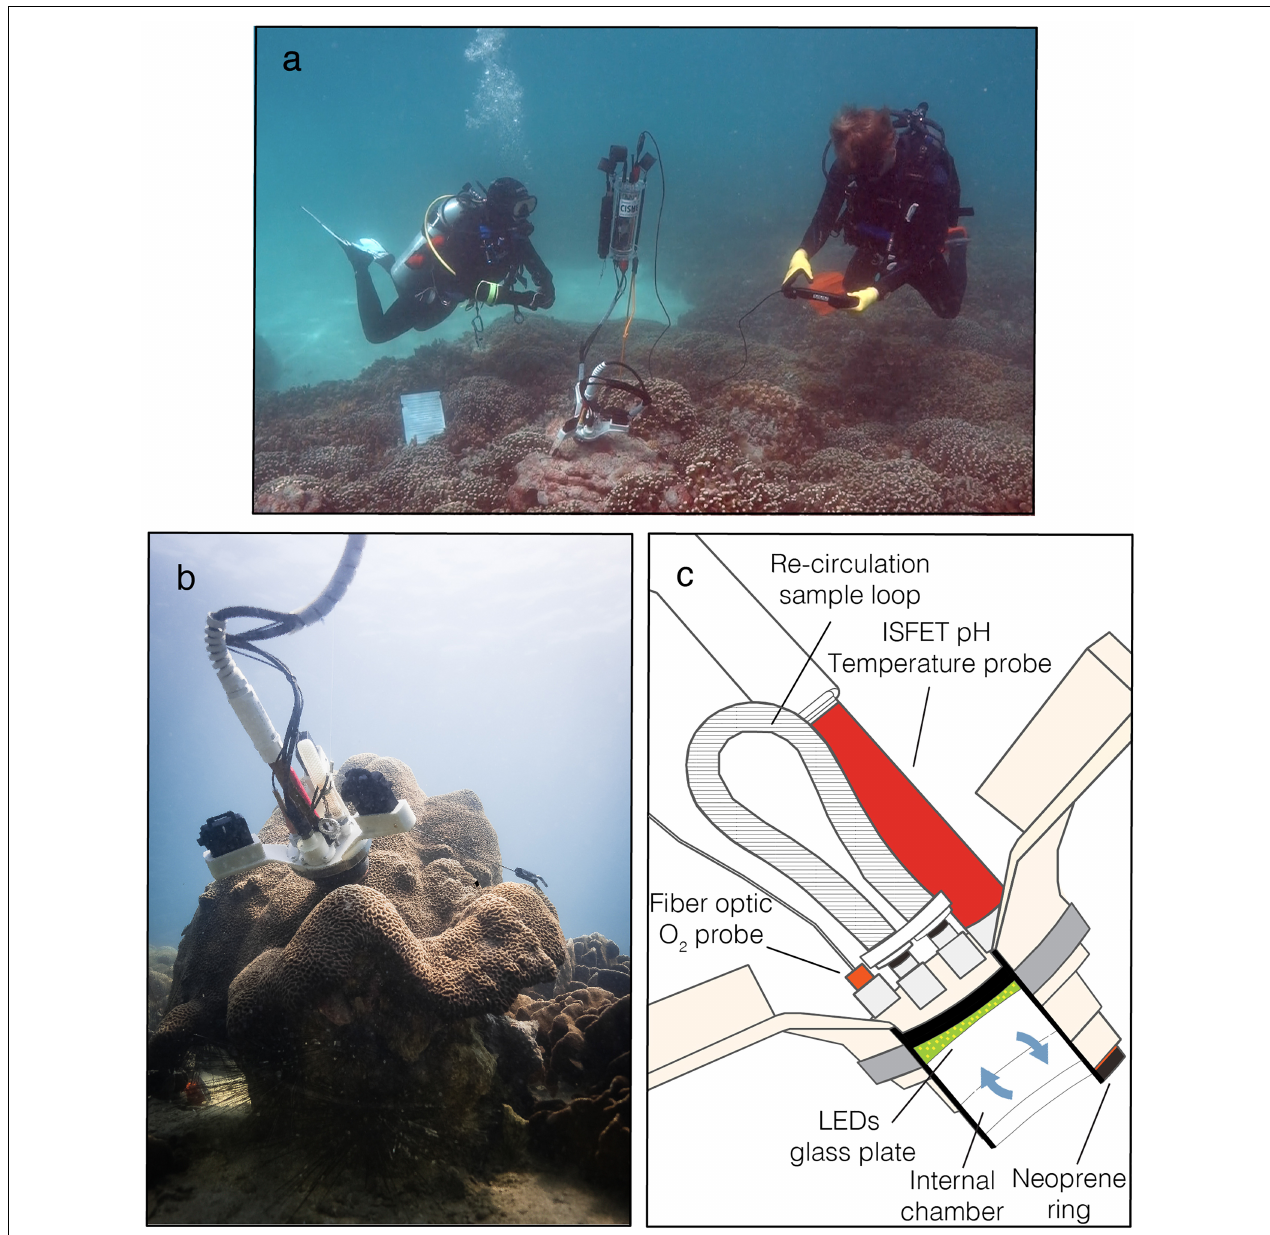
FIGURE 1 | The CISME system operated by SCUBA divers to survey shallow coral colonies. The system simultaneously measures temperature and changes in dissolved oxygen and pH on flat surfaces of stony corals under regulated light and dark conditions. (a) The whole system includes the electronic housing, the incubation head and the tablet. The housing is slightly positive while the incubation head is deployed on surveyed coral. The divers can control the system and adjust the settings using the tablet according to the experimental investigation. Underwater photo credits: Dr. Alina Szmant. (b) Close-up of CISME deployment: the incubation head is attached to the coral surface with retractile anchors that allows the sealing during the incubation. (c) The technical detail (perspective section) of incubation head shows sensors and the LEDs illumination array. The seawater is being recirculated within the chamber and a discrete water sample can be collected through the removal of sample